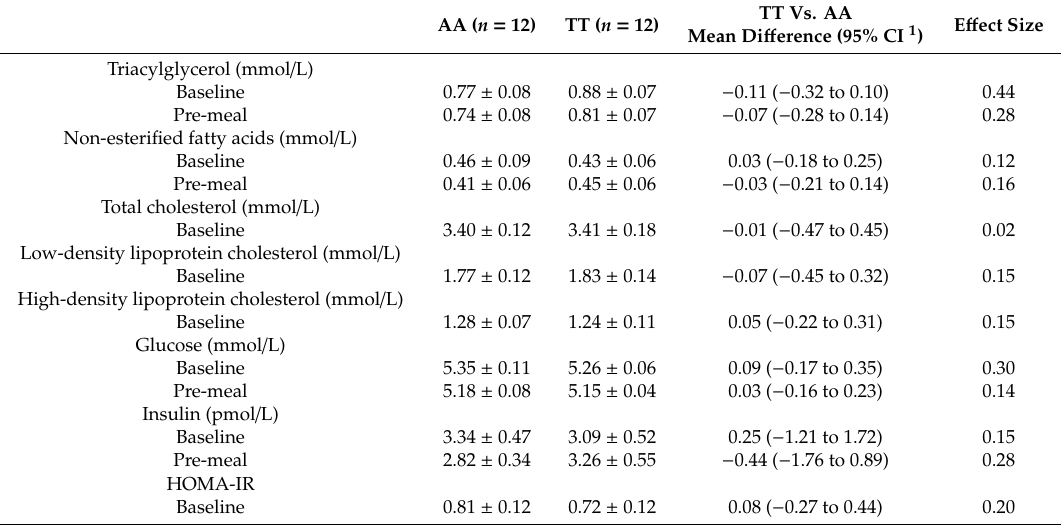
Table 2. Fasting plasma concentrations and HOMA-IR at baseline ( − 1.5 h) and pre-meal (0 h) in AAs and